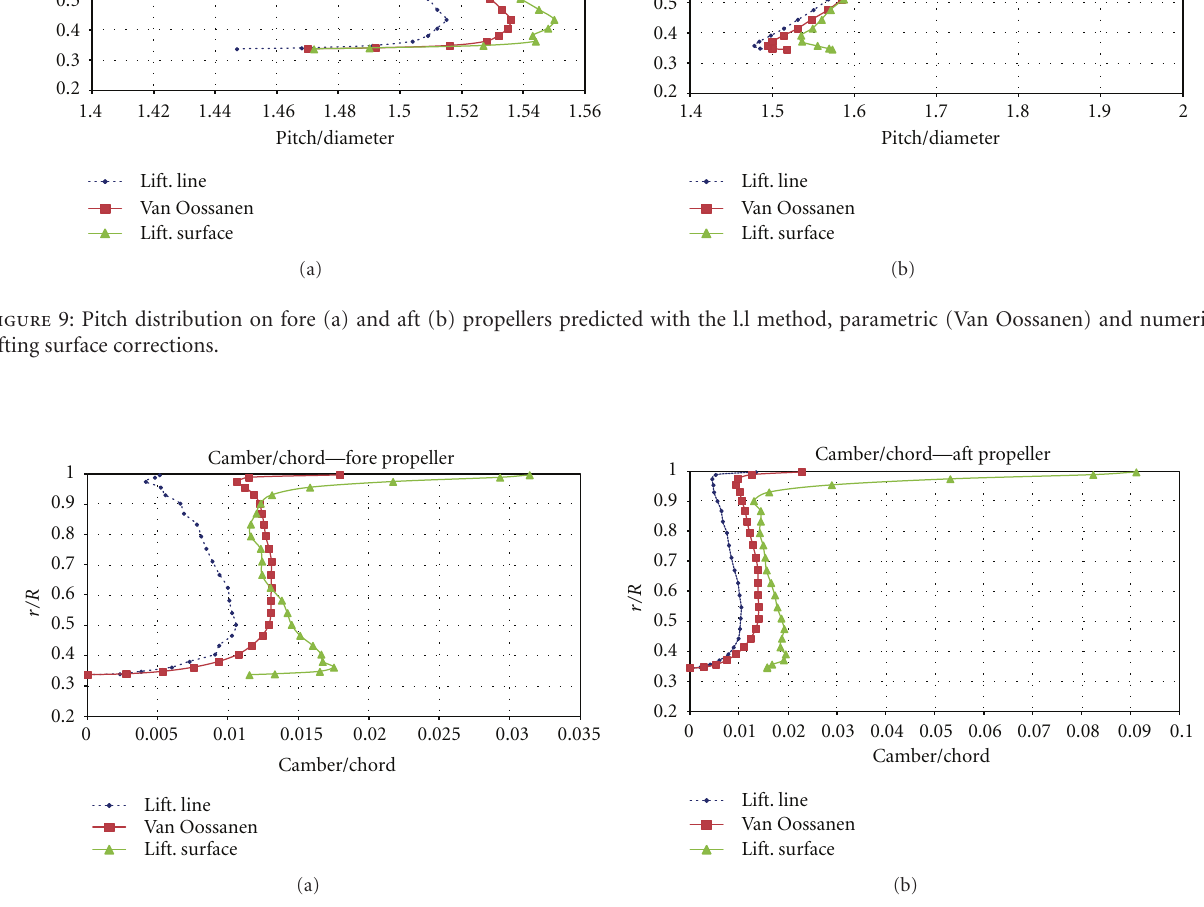
Figure 10: Camber distributions on fore (a) and aft (b) propellers predicted with the l.l method, with parametric (Van Oossanen) and numerical lifting surface corrections.